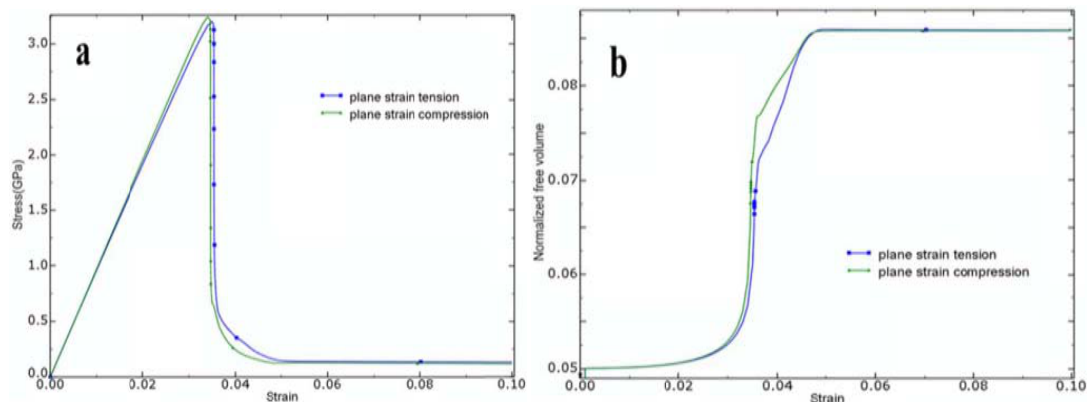
Figure 4. The results from plane strain tension and compression using the J stress strain curve and ( b ) the free